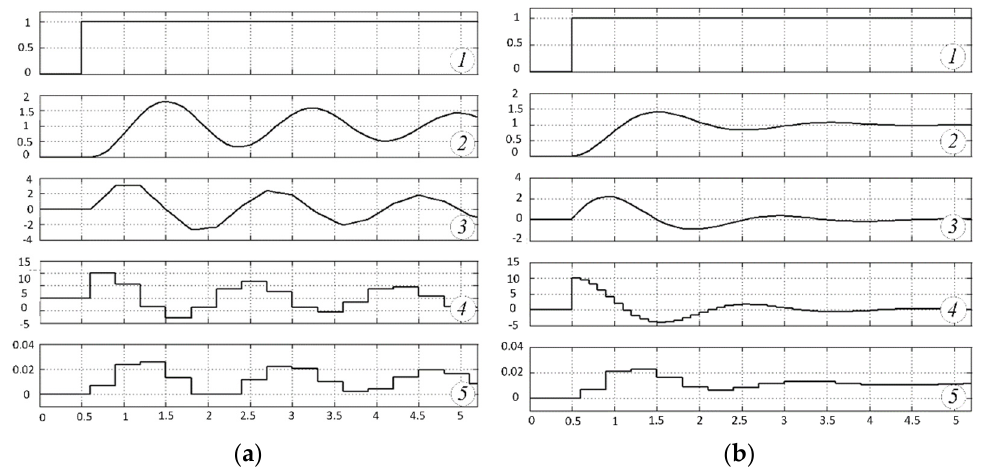
Figure 6. Transient processes in an automatic control system with PID controllers with a changed sampling frequency: ( a ) oscillatory processes in an ACS with a PID controller, with a total discreteness in all control channels of 0.3 s; ( b ) stable processes in the ACS with a discreteness in the D − channel of 0.1 s and discreteness of 0.3 s in the I and P control channels) 1 Reference signal. 2 Controlled variable. 3 Derivative of the controlled variable. 4 Output signal of the differentiating channel of the controller after sam- pling. 5 Output signal of the integrator.